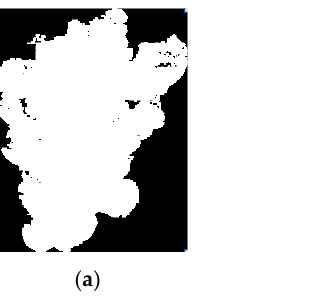
Figure 16. Extraction of the front grape cluster. ( a ) Front cluster with holes, and ( b ) the front cluster with no holes.